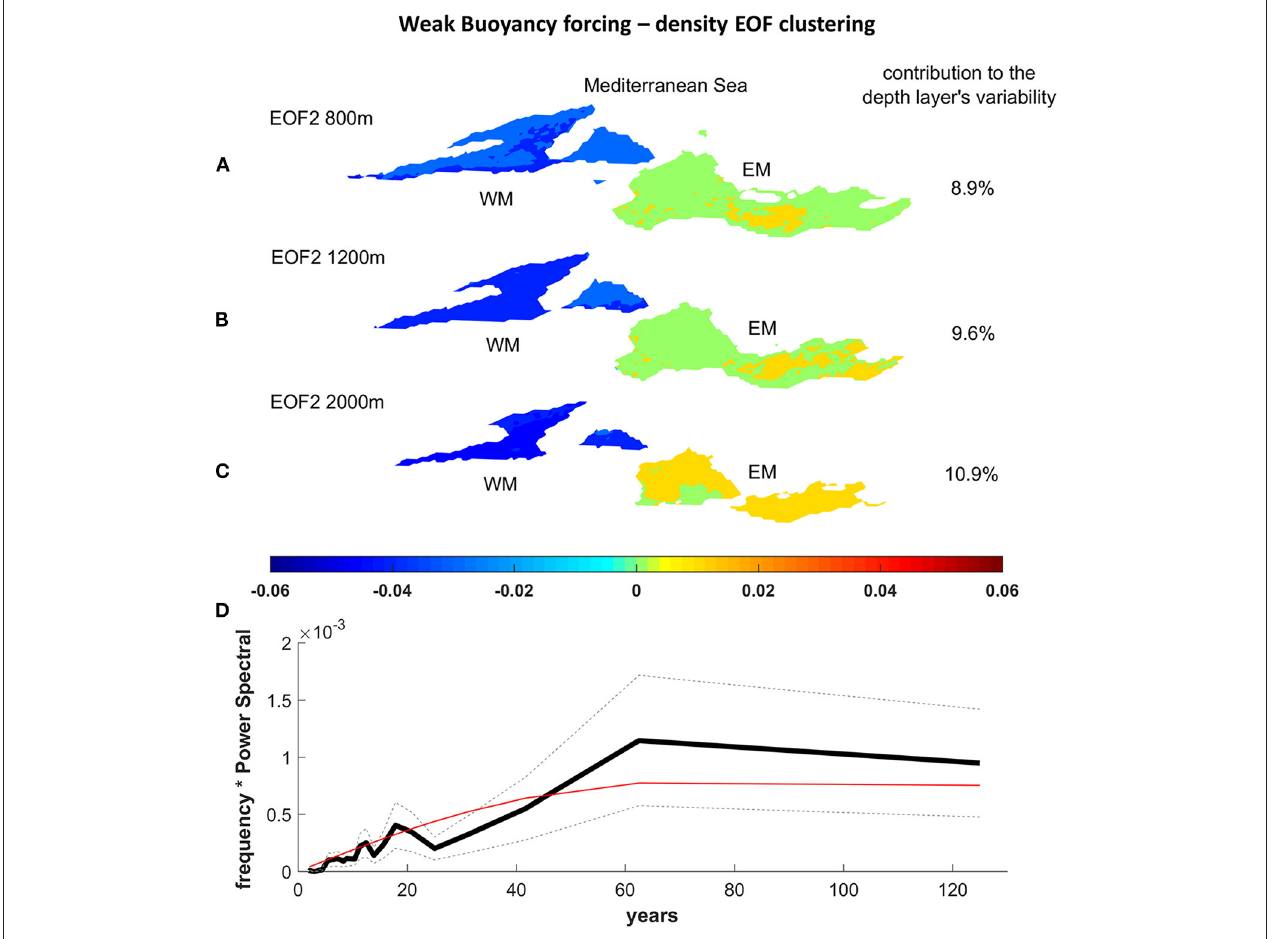
FIGURE 14 | The second EOF modes of 800, 1,200, and 2,000m depth (A–C) of the WBF experiment, whose expansion coefficients are well-correlated. Here, the variance-preserving spectrum of the 2,000m second EOF is presented as (D) .